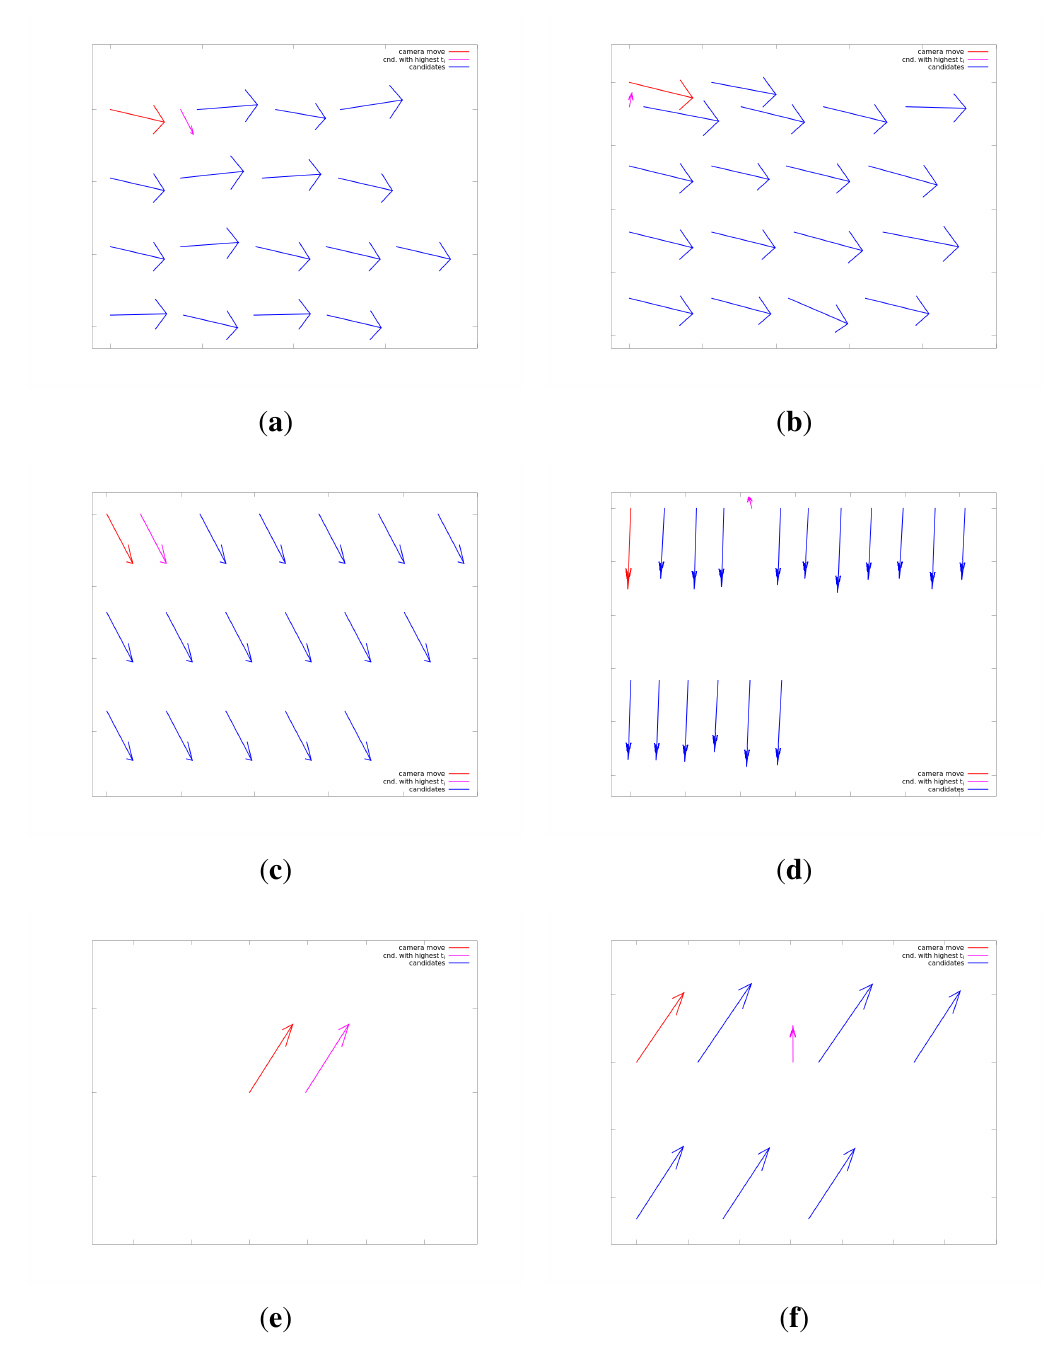
Figure 9. Motion vectors (cid:126)c for detections on different distances. ( a ) Motion vectors, max i distance 5 m; ( b ) motion vector, max distance 5 m; ( c ) motion vectors, max distance 10 m; ( d ) motion vectors, max distance 10 m; ( e ) motion vectors, max distance 40 m; ( f ) motion vectors, max distance 40